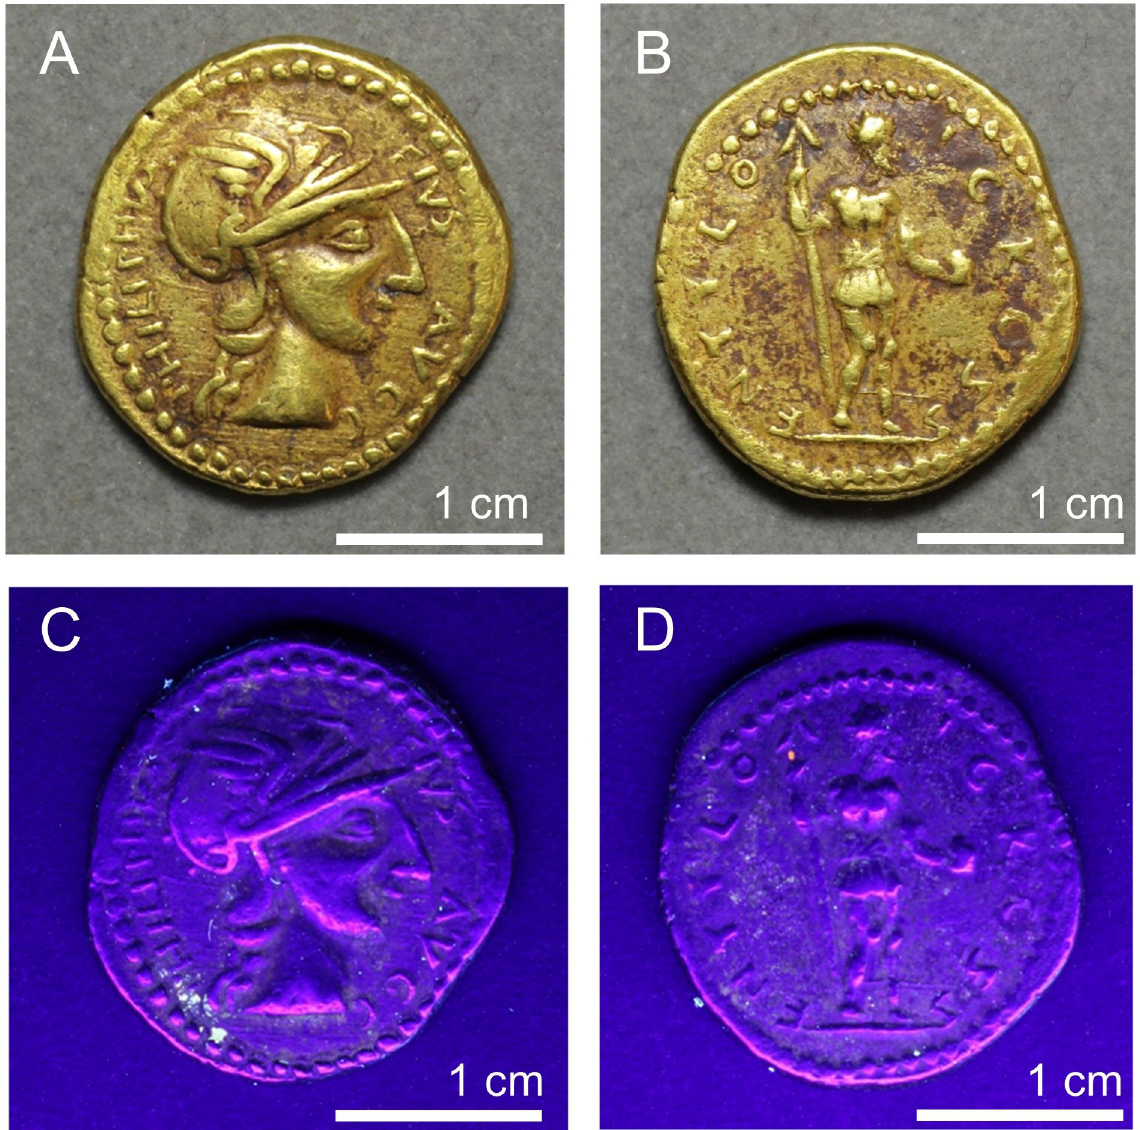
Fig 9. Coin GLAHM:29821 in visible and UV light. Areas of white fluorescence at the bottom of the bust on the obverse and in the left field of the reverse correspond to areas of reddish deposit, although not all such areas fluoresce as brightly. Note the small area of bright orange fluorescence near the spear point which is discussed in the